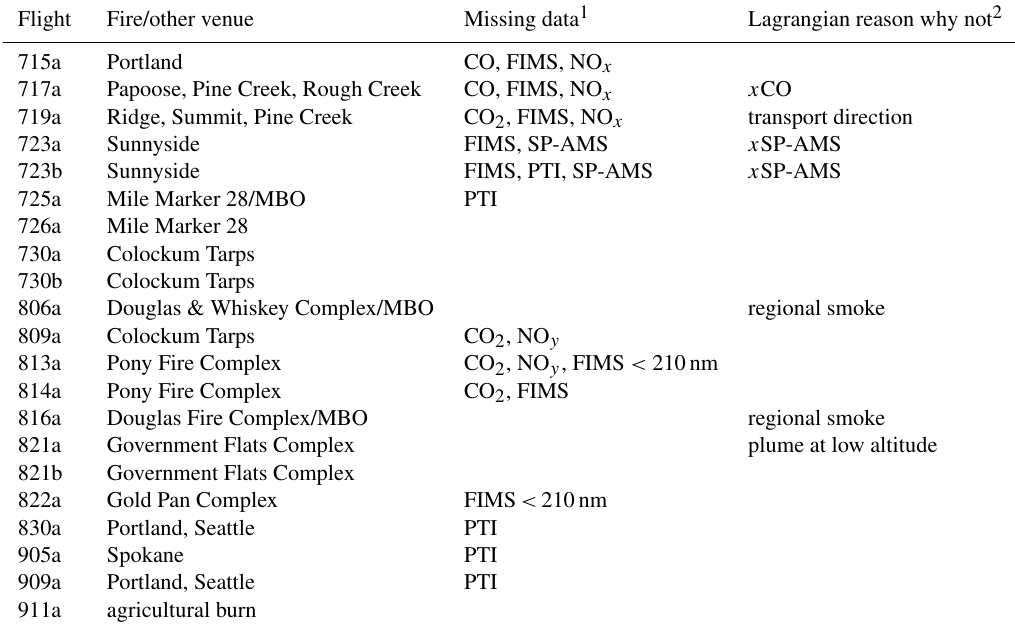
Table 2. Synopsis of BBOP research flights in the Pacific Northwest.